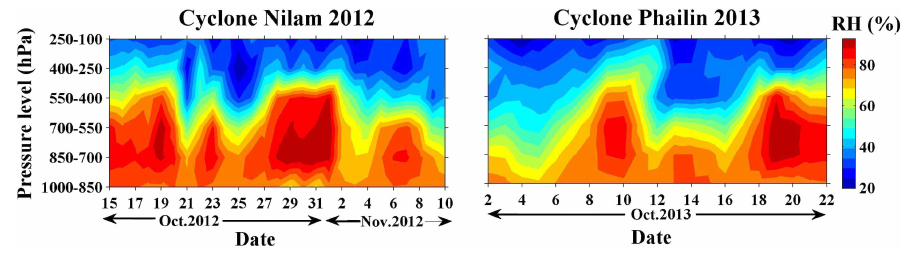
Figure 7. Pressure–time cross section of relative humidity obtained from SAPHIR on board the Megha-Tropiques satellite during the cyclones Nilam (left panel) from 15 October to 10 November 2012 and Phailin (right panel) from 2 to 22 October 2013. The data is averaged over from 4 to 8 ◦ N and 83 to 88 ◦ E.